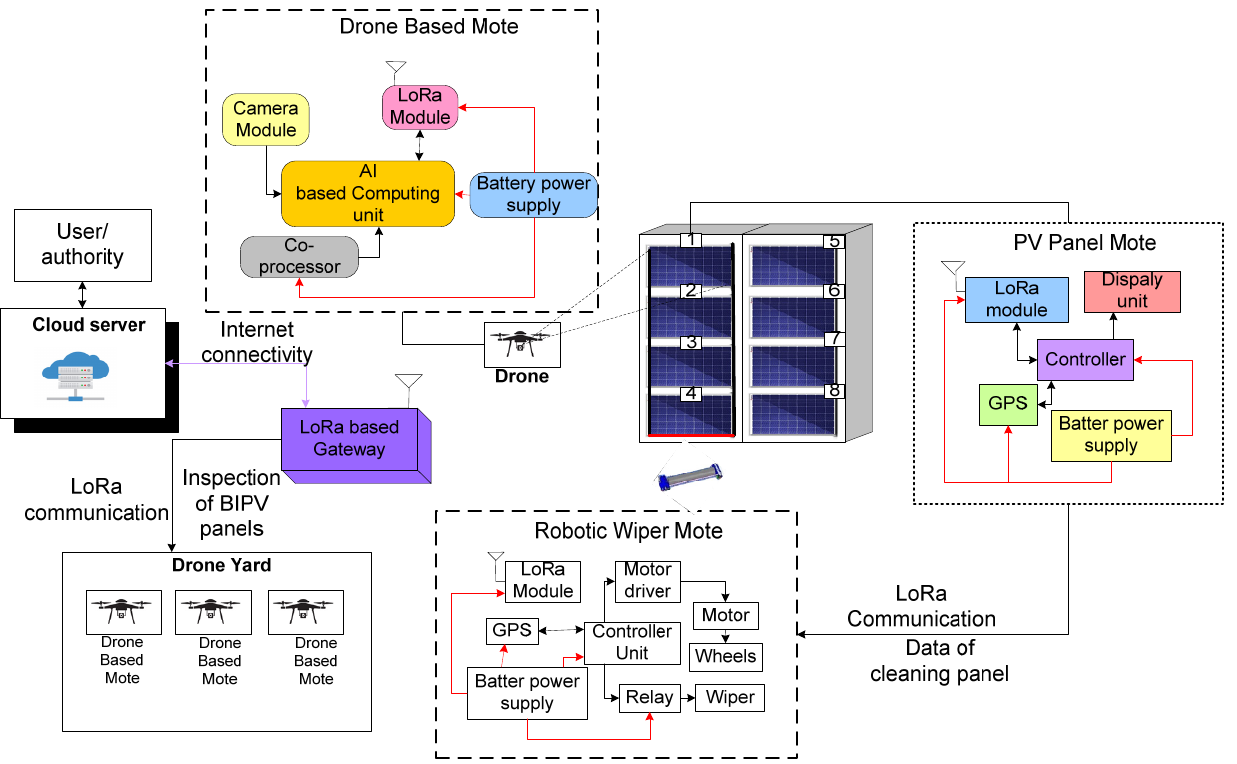
Figure 24. Proposed architecture for the robotic and drone-based automatic wiper system. Drone-based mote embedded in the drones enables to detect the dust based on visuals obtained through the camera module. The obtained images are computed on the AI-based computing unit with co-processor to identify the dust in real-time. If the dust is identified, then the drones instruct the PV panel mote to send the GPS location to the robotics wiper mote through the LoRa communication. Here the PV panel mote is embedded in every panel so that every panel will be connected with the drone-based mote and robotic wiper mote through LoRa communication. Based on the request from the particular PV panel mote, the robotic wiper mote enables the robotic wiper system to locate and clean the dust on the BIPV panels. Simultaneously, it receives the request from the other PV panel mote, then it moves to that location and performs a cleaning activity. Along with building struc- ture and area, the complete system can be customized. 5. Future Directions and Research Challenges This study has discussed the significance of the digitalization implementation in BIPV for achieving a resilient infrastructure. Initially, we presented an overview of the BIPV sys- tem, and later on, the discussed digital technologies that are suitable for digitalization. A high temperature of BIPV system, fault identification in BIPV system, and dust accumula- tion of BIPV system are areas where the significance of digitalization is identified and the proposed architecture is relevant. However, few parameters can be improved for the better implementation of digitalization in the BIPV system. Below, the discussion and recommen- dations are provided to enhance the few parameters, and they are as follows: 5.1.Next Generation Computing for Digitalization of the Photovoltaic Integration (a) Future directions According to the findings of the above analysis, digitalization integration in the BIPV system is minimal. The adoption of digitalization has previously been proven in a variety